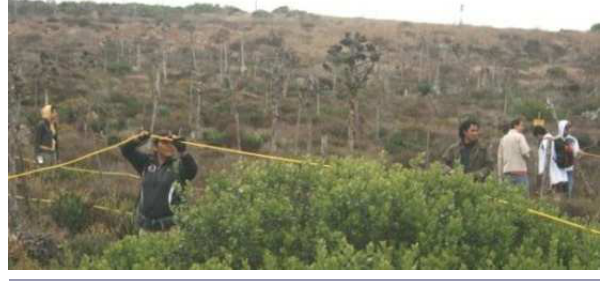
Fig. 12. Ecological research in the